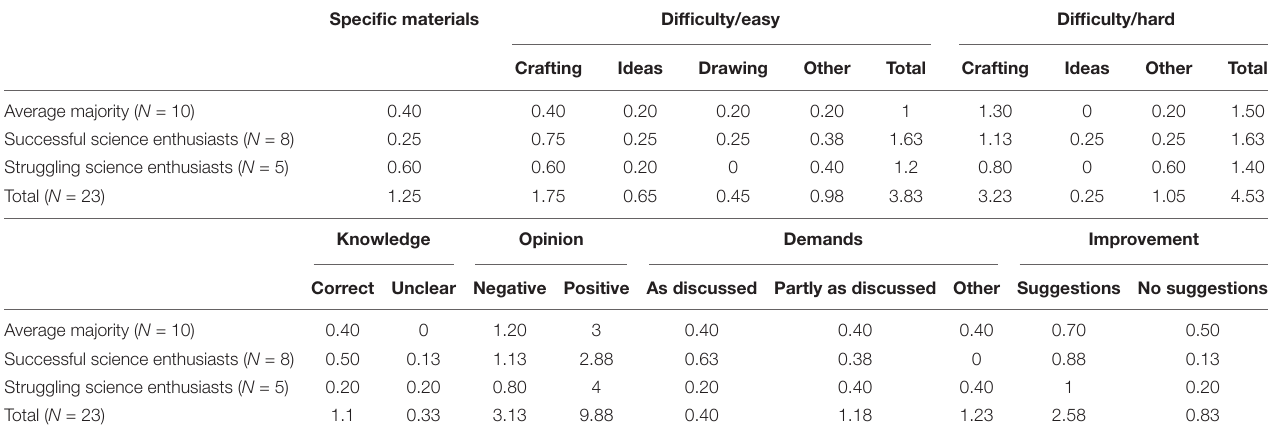
TABLE 8 | Code frequencies of the code groups per profile, divided by the profile sample size, for lesson 3